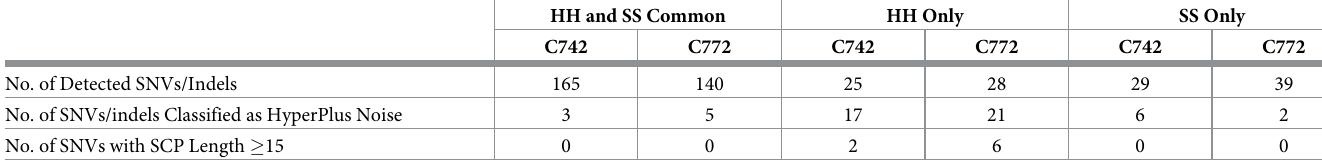
Table 2. Somatic mutation calling with the same DNA fragmentation method in pairs of normal and tumor